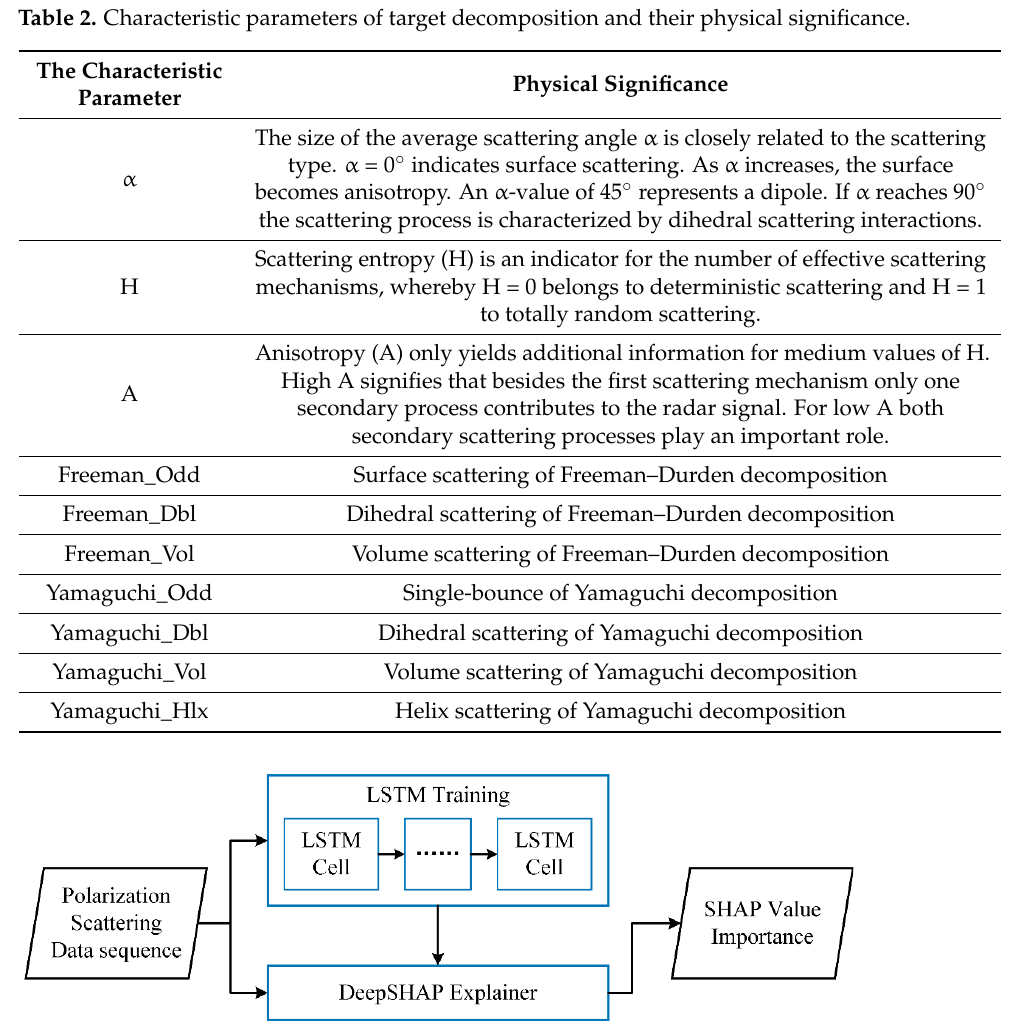
Figure 4. Structure of SHAP ‐ based physical feature interpretable module.